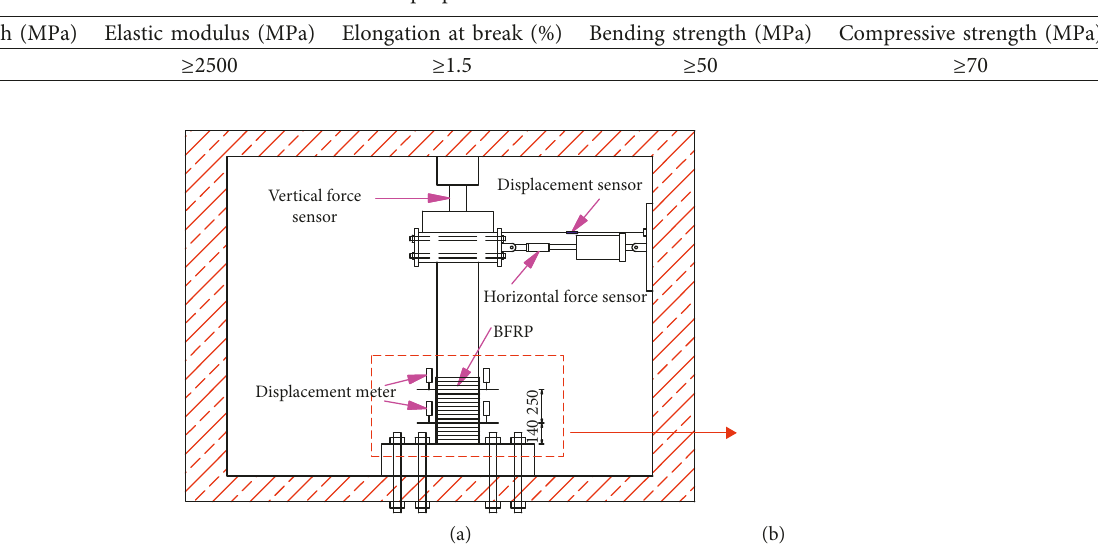
Table 4: Colloidal properties of carbon fibre adhesive.